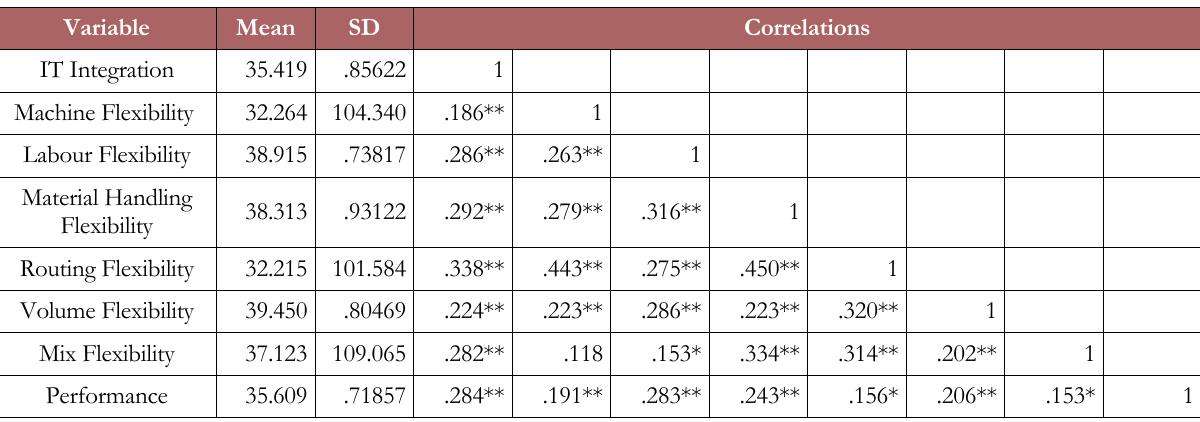
Table 4. Descriptive statistics and reliability